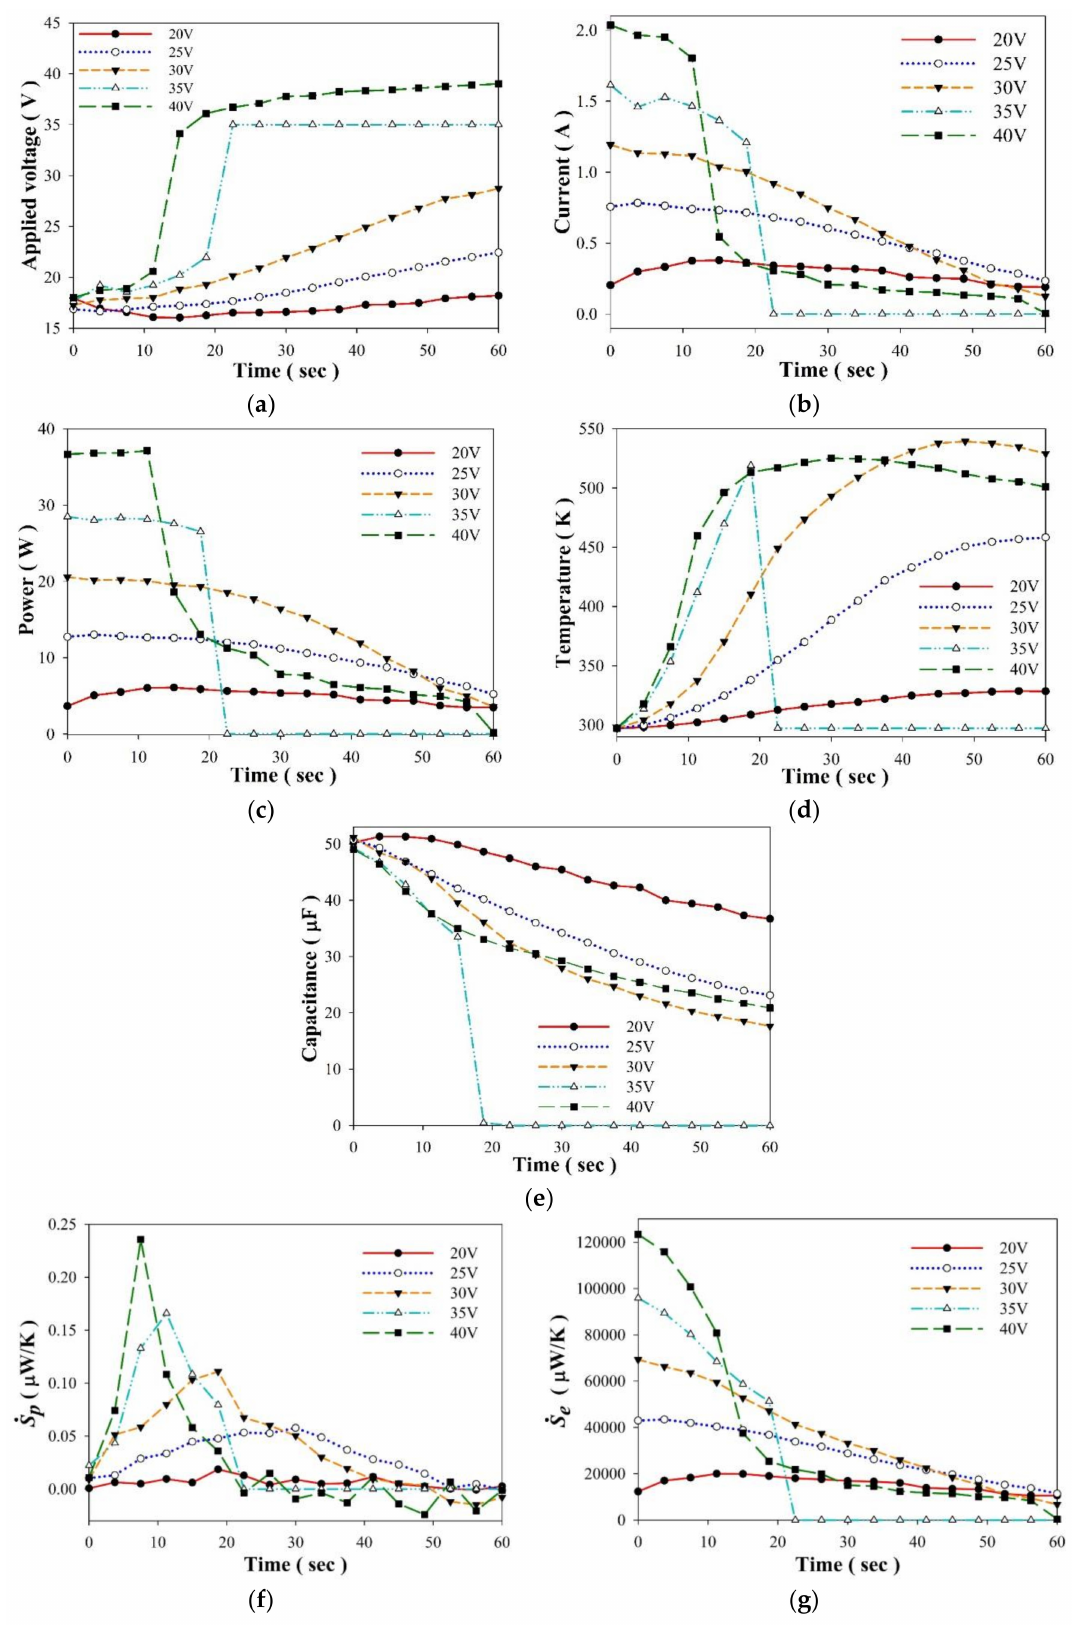
Figure 8. Time evolution of: ( a ) applied voltage, ( b ) current, ( c ) power, ( d ) temperature, ( e ) capacitance, ( f ) entropy generation rate ( ´S p ) by the pyroelectric cell, and ( g ) entropy generation rate ( ´S e ) by the electrical system for the selected capacitor with a capacitance of 47 µ F and a maximum endured voltage of 4 V. The PZT cell had a dimension of 3 mm square and a thickness of 200 µ